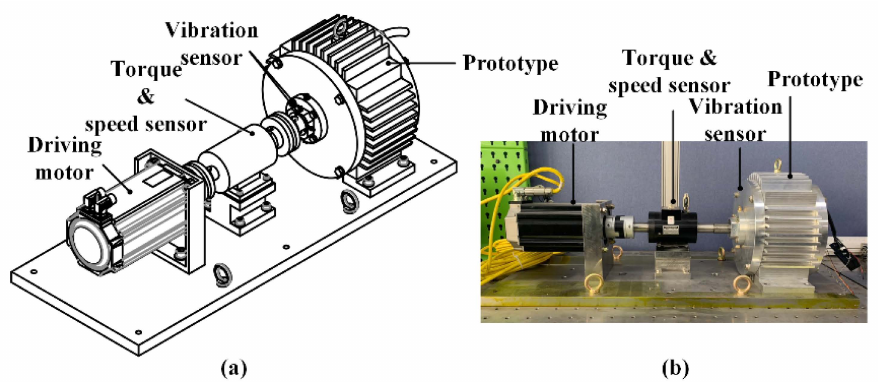
Figure 14. MG set for experimental evaluation: ( a ) schematic; ( b ) actual system. For the driving motor (MPP1426P6S-KPSN), a servomotor was selected to